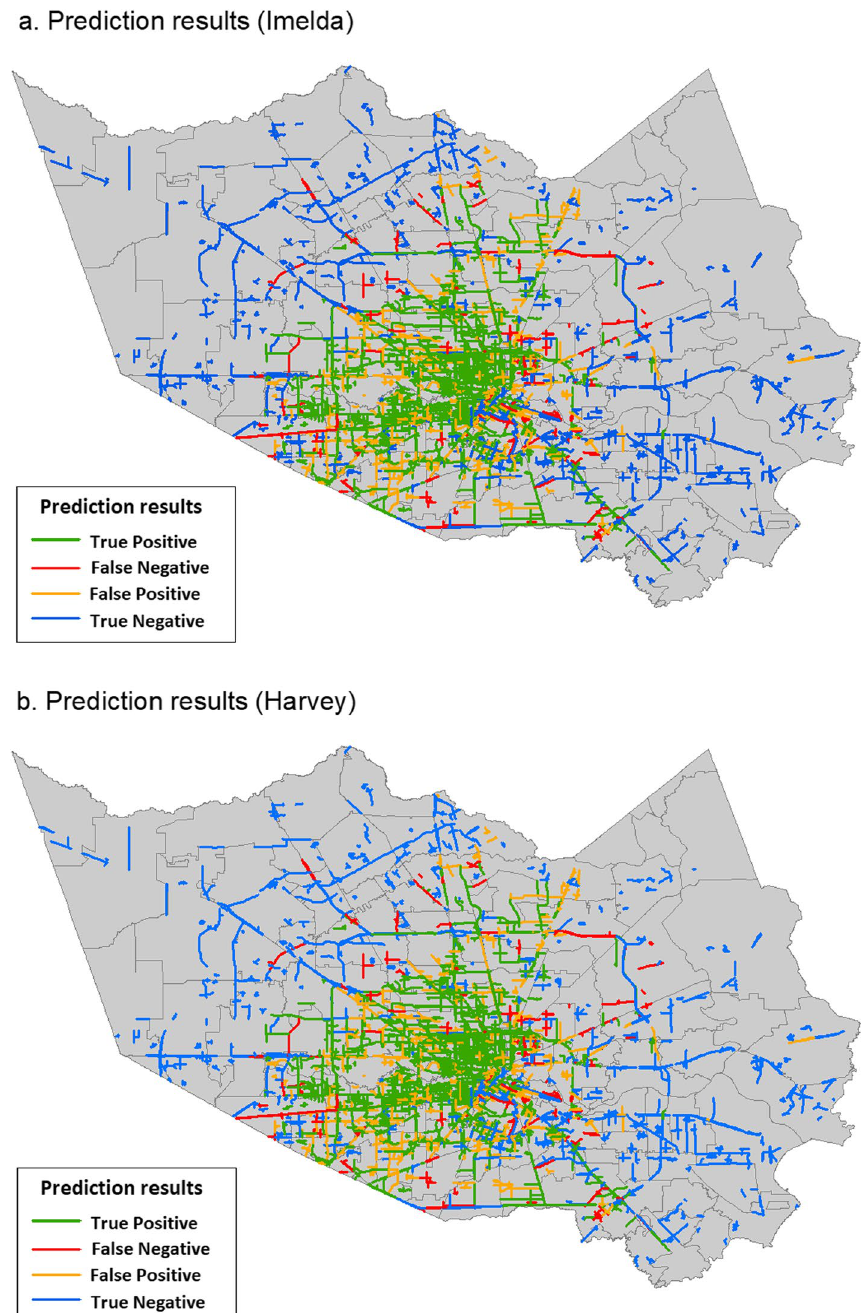
Fig. 8 Examples of prediction results for roads with and without flood risks for Tropical Storm Imelda ( a ) and Hurricane Harvey ( b ) according to the predicted probabilities in Figs. 7a and 7b, respectively. Each link represents the road with road point used for model test. For better presentations, we show only the roads used in our test